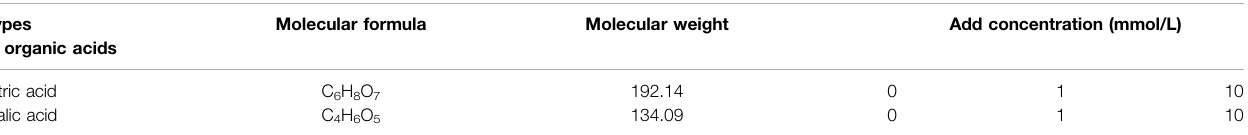
TABLE 2 | Concentration of organic acids